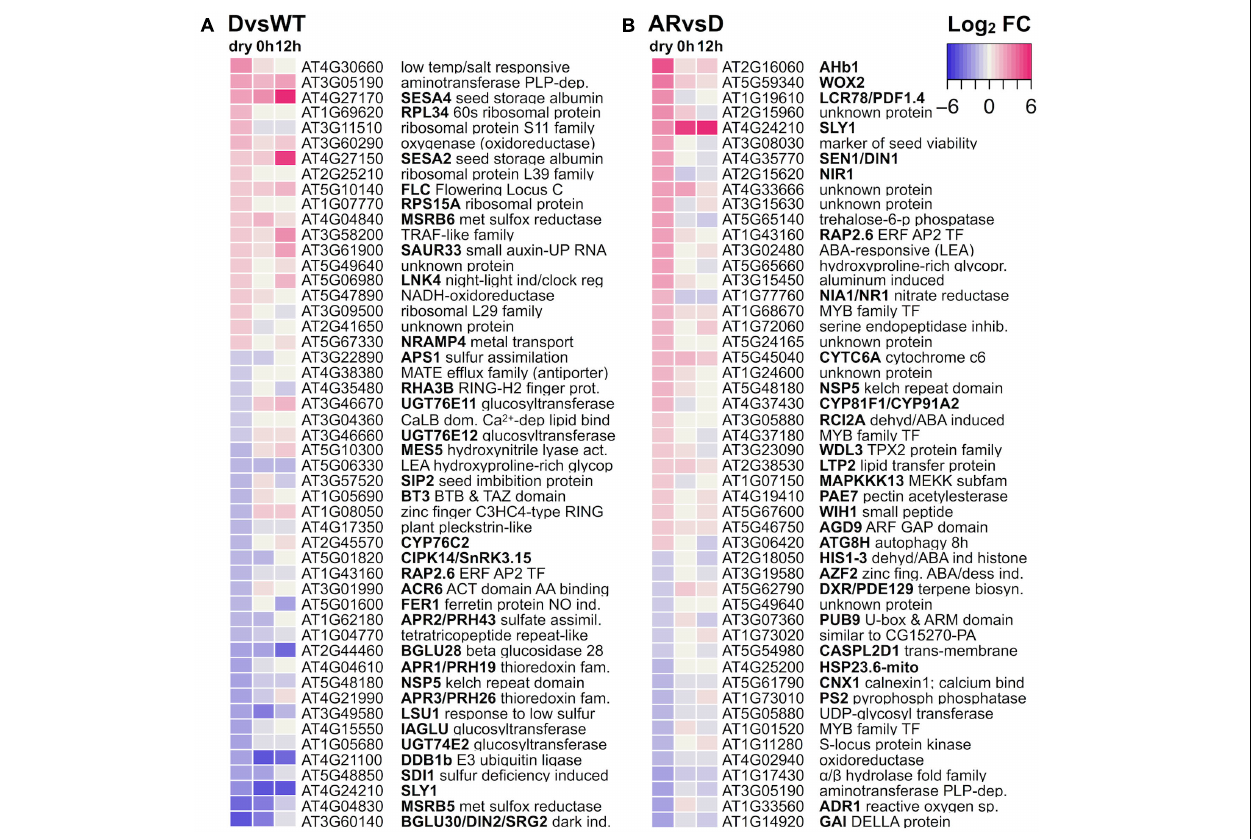
FIGURE 3 | The top 50 largest log 2 -fold change differences in and their transcriptome differences in imbibed seeds. Differences are plotted as a heat map of dry seed values with comparison to the same comparison at 0h and 12h imbibition timepoints from Nelson and Steber (2017). (A) Between sly1-2 (D) and L er wt dry seeds (DvsWT) and (B) between after-ripened and dormant sly1-2 (ARvsD) dry seeds. Throughout this work, up-regulation is indicated in red and down-regulation in